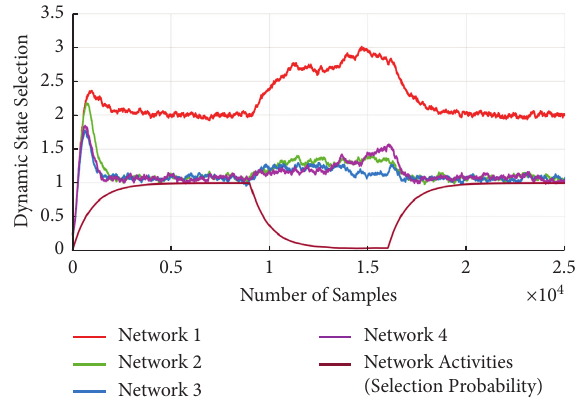
Figure 21: Effect of threshold on network connectivity for threshold � 2 ( S l �